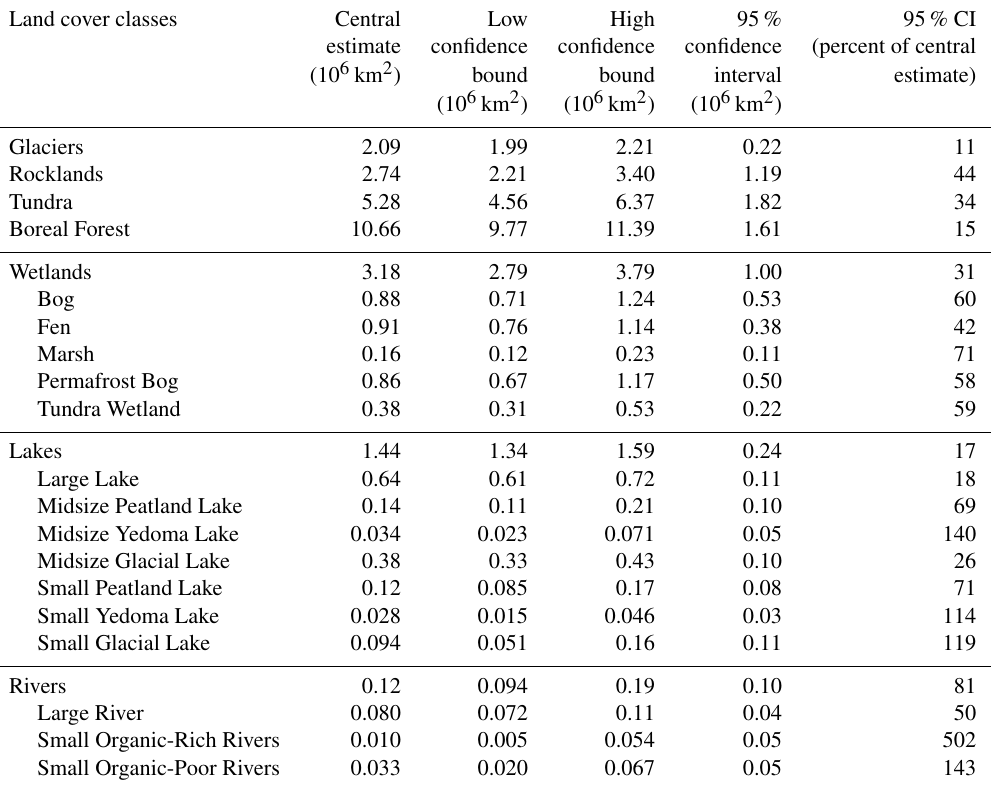
Table 3. Summary of central estimates, 95% low and high confidence bounds, and the range of the 95% confidence interval expressed as a percent of the central estimate for each of the land cover classes within the BAWLD